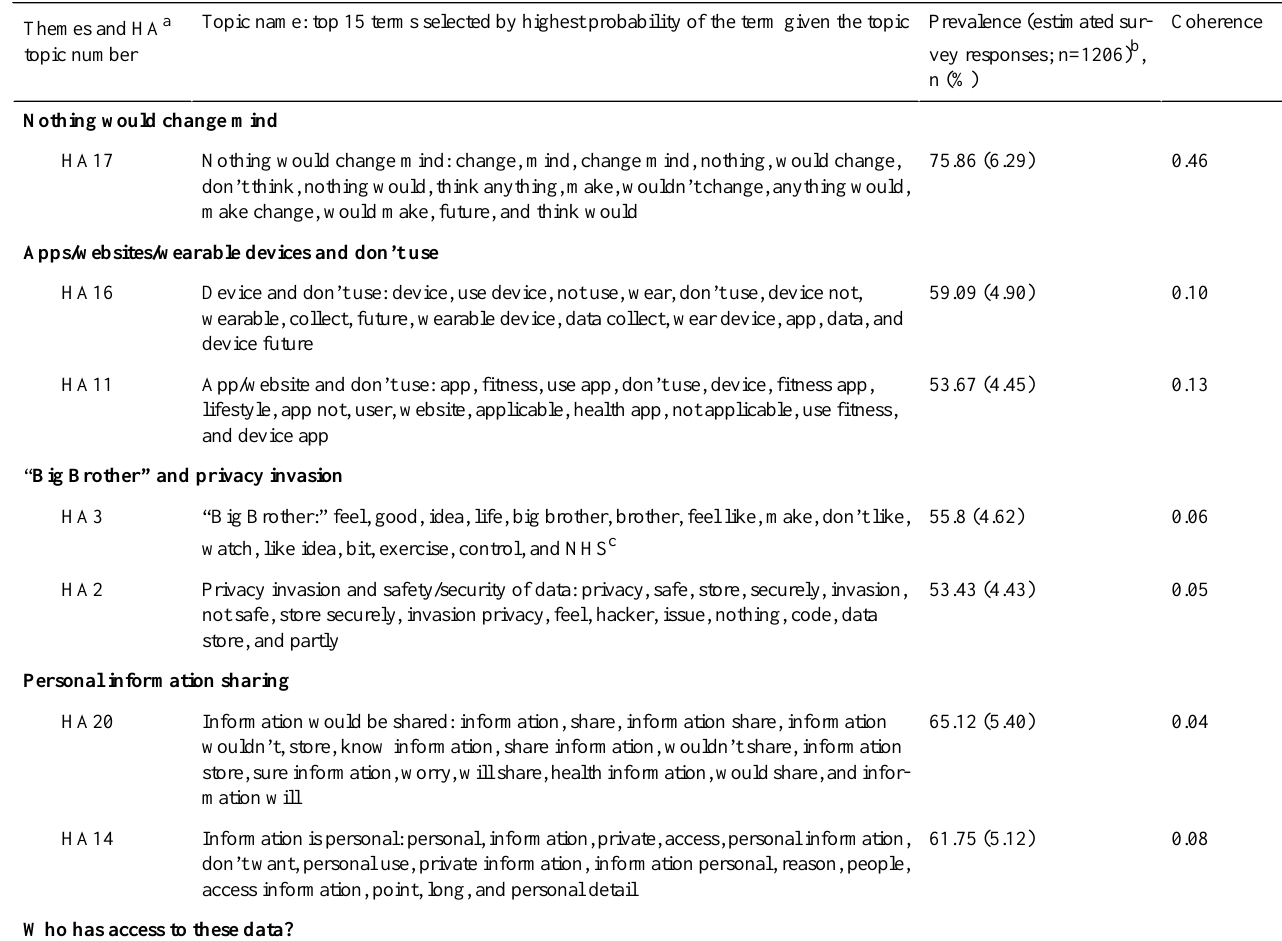
Table 4. Topics created by latent Dirichlet allocation modeling of the LifeInfo health and fitness app question.